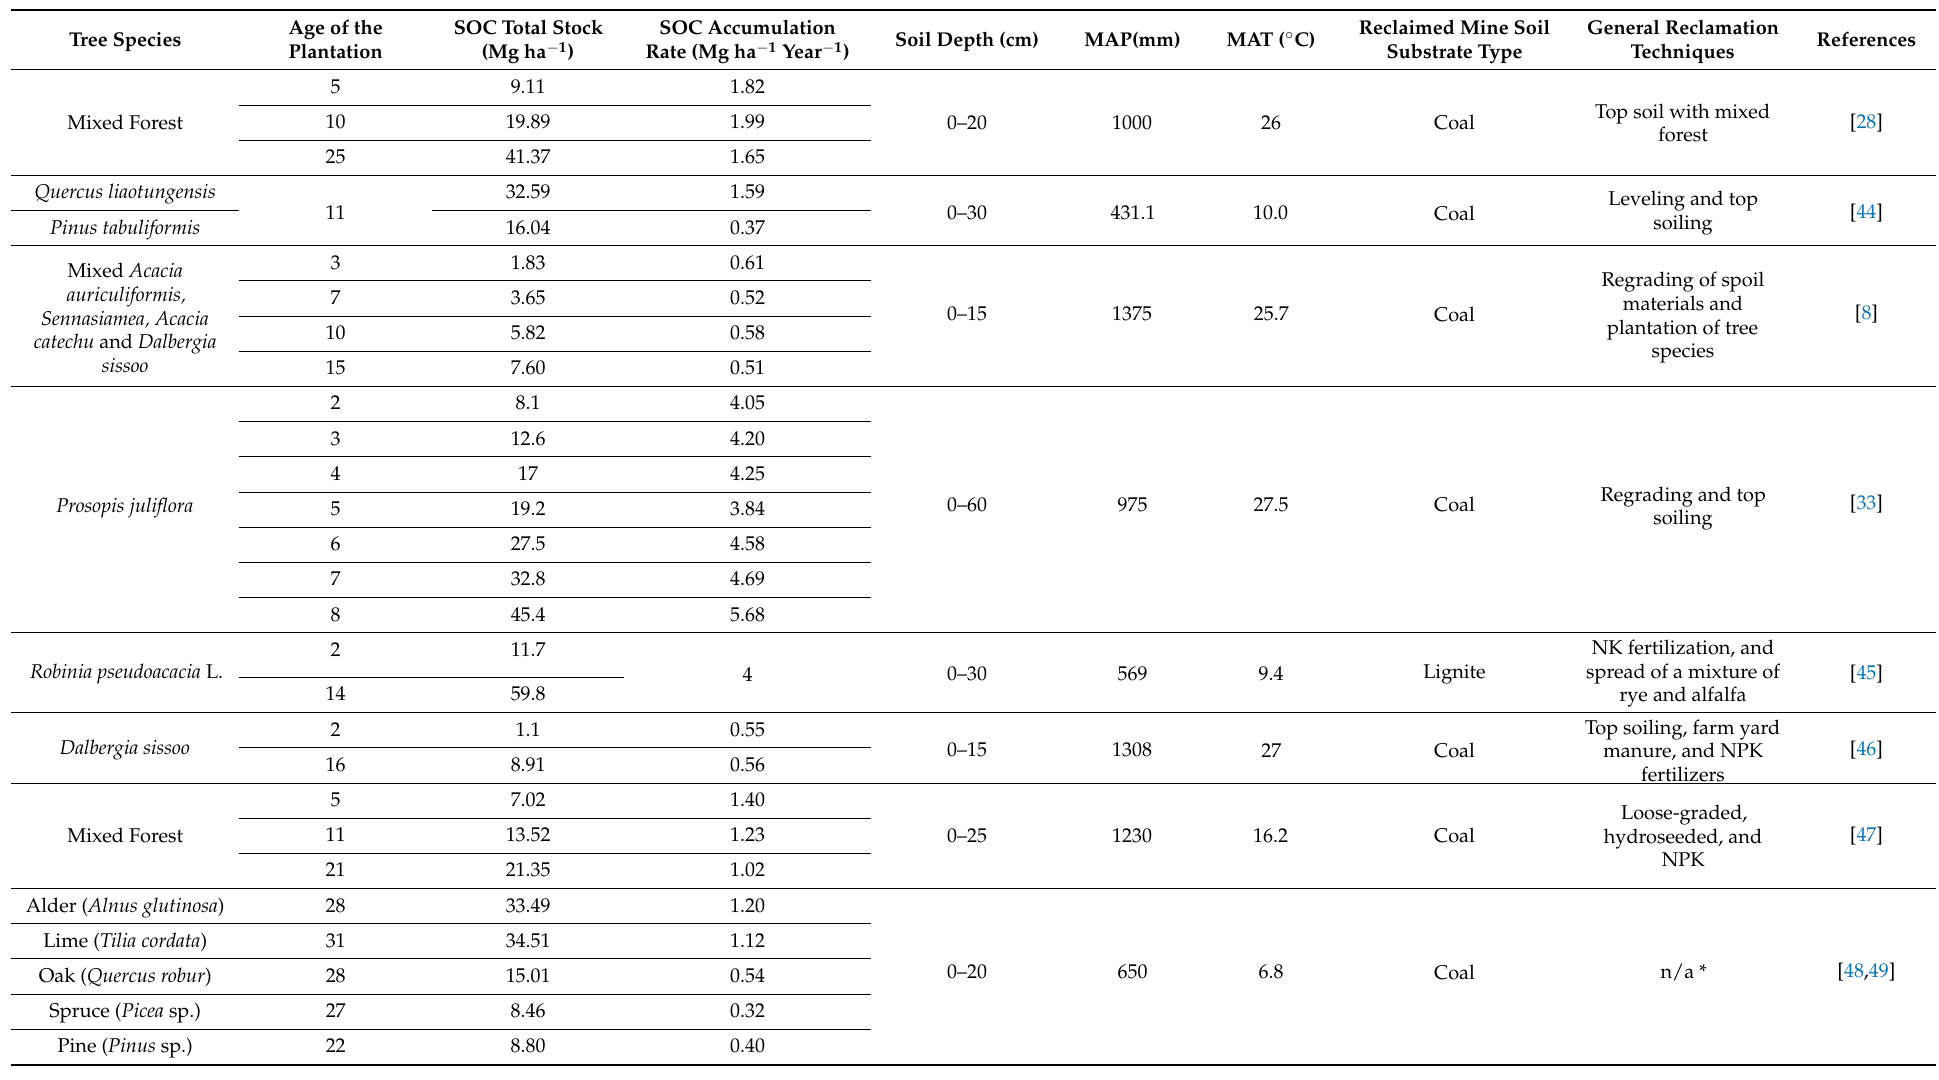
Table 1. The effect of age on soil organic carbon